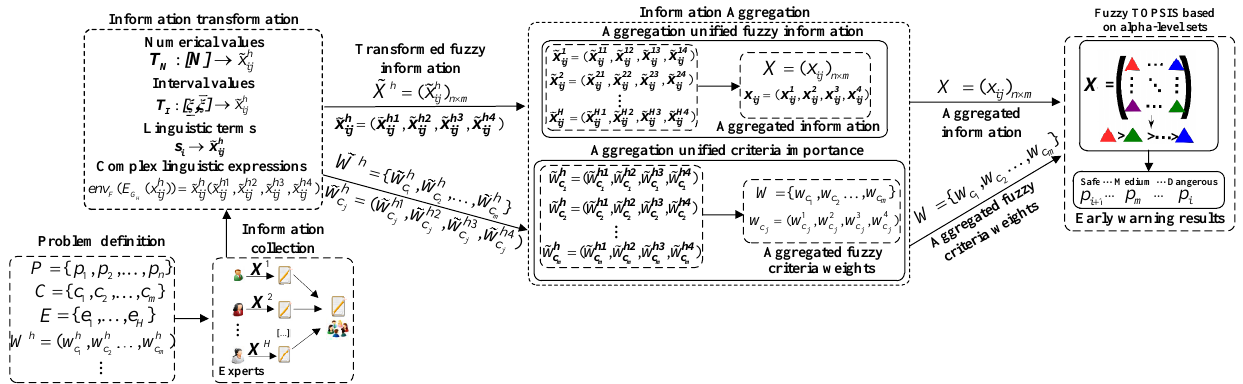
Figure 2. The general framework of the proposed